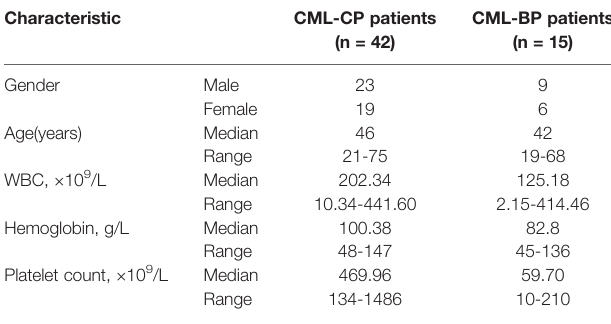
TABLE 2 | Patients'